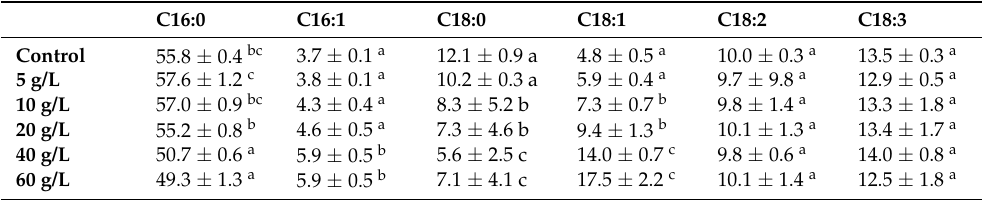
Table 4. Fatty acids profile of A. platensis grown at different salinities ( n = 3, ± SD). The different superscript letters denote statistically significant